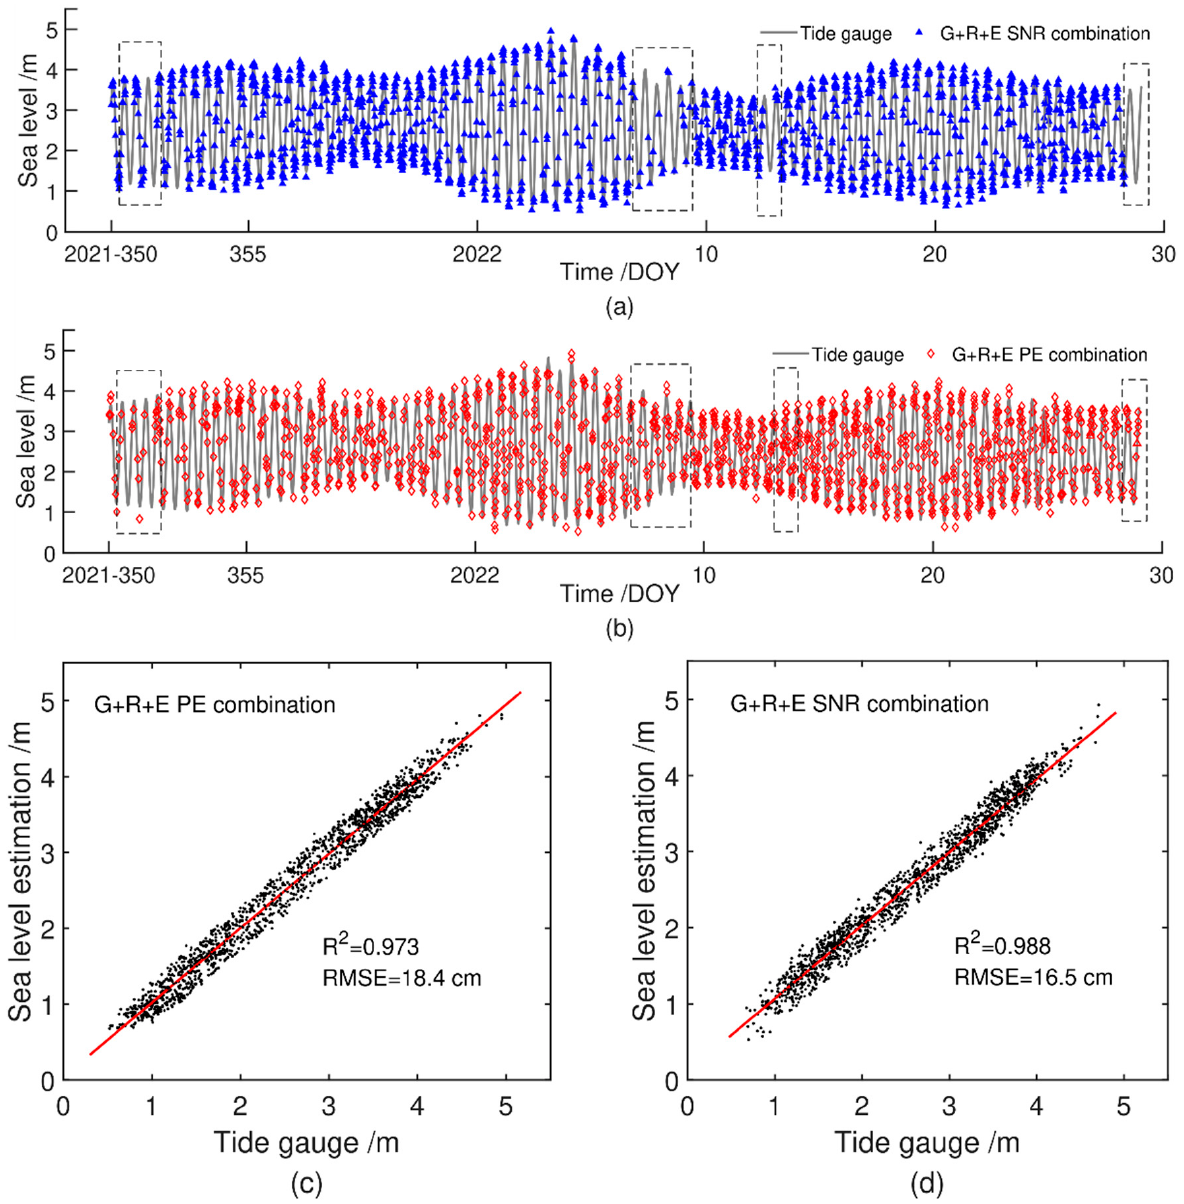
Figure 14. Sea surface height of site SCOA estimated by the combined PE and SNR arcs for different constellations, respectively, and linear relationship between retrievals and in situ tidal data. ( a ) A combination of multi-GNSS PE arcs; ( b ) a combination of SNR arcs collected from GPS S2X, GLONASS S2C, and Galileo S5X; ( c ) the corresponding linear relationship for GNSS PEs; ( d ) the corresponding linear relationship for GNSS SNR. Table 5. The average number of retrieval points per day, slope of regression line, RMSE, and corre- lation for both PE combination and SNR combination methods.